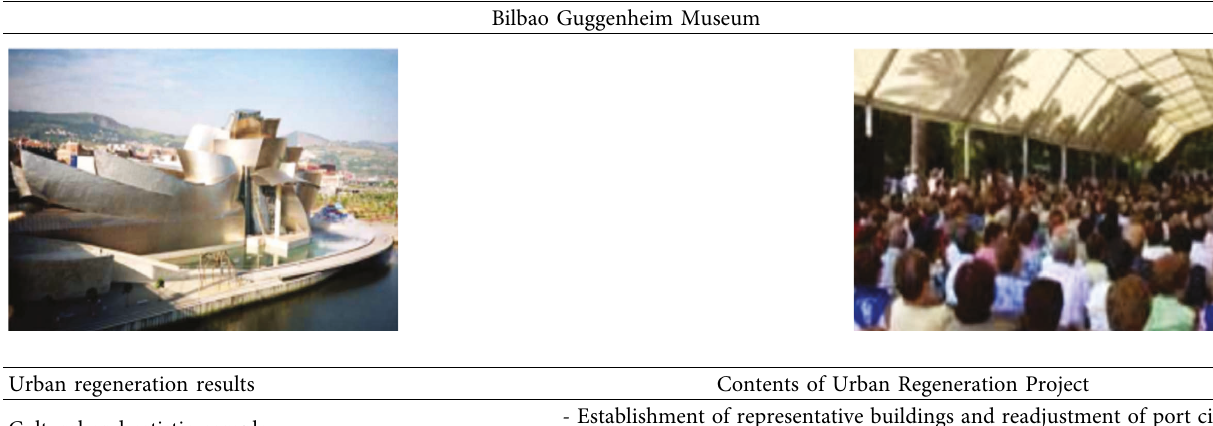
Table 5: Result of urban regeneration in Bilbao Guggenheim Museum.